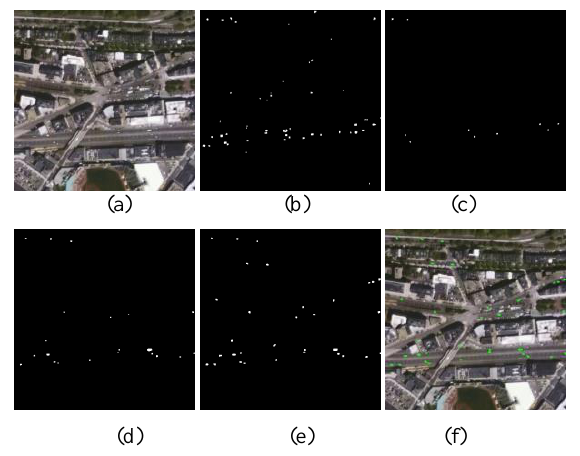
Figure. 7. Original data and all kinds of detection results of UrtheCast. (a) original image data, (b) FD, (c) GMM, (d) ViBe, (e) TCD, (f) ture image Table 3 Evaluation and comparison of each detection algorithms of the